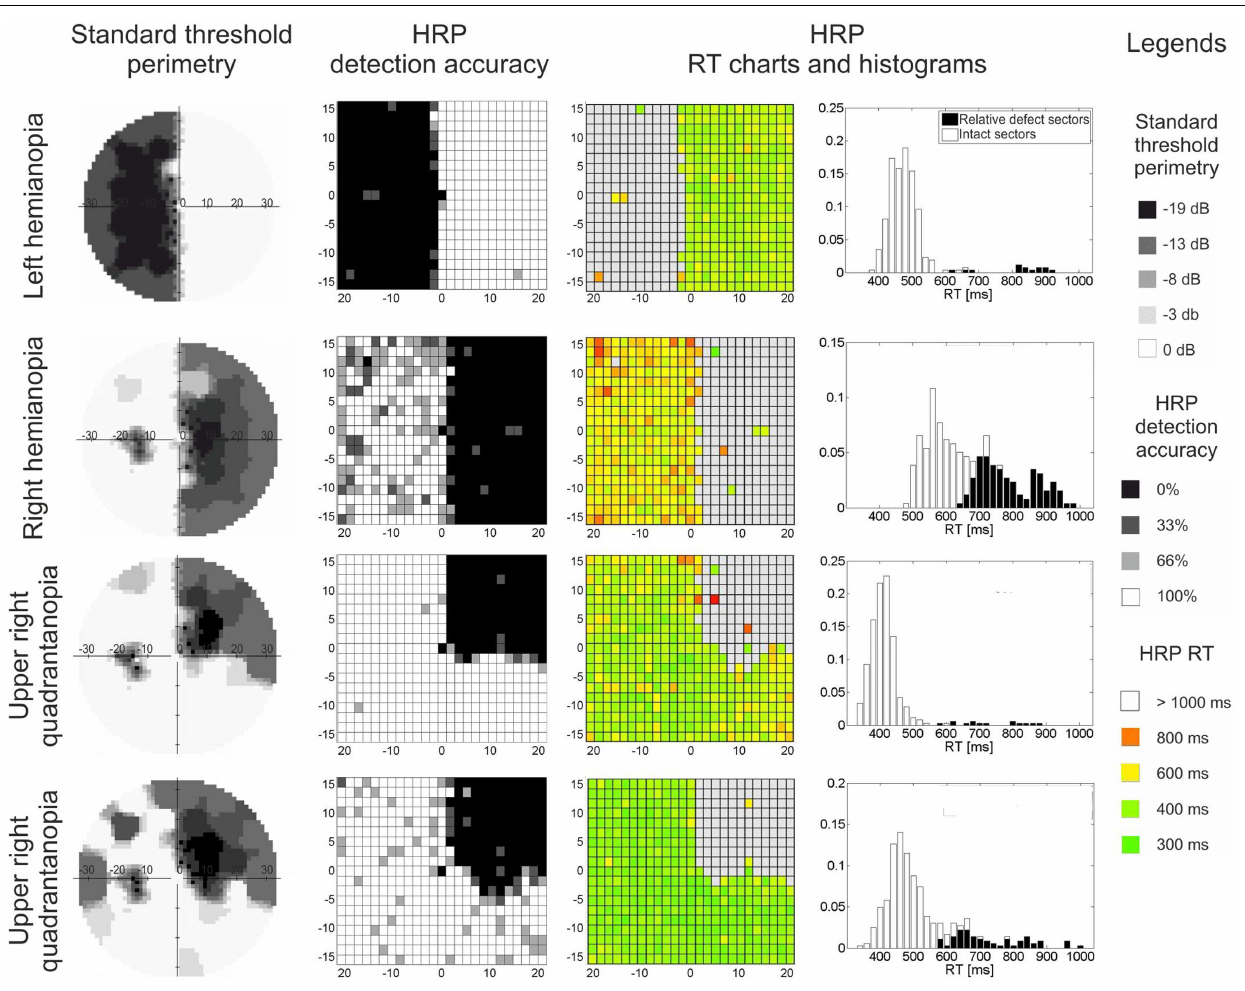
FIGURE 1 |Visual field maps of four patients with visual field loss due to post-chiasmatic damage .Two types of visual field maps are shown: standard perimetry and high resolution perimetry (HRP), both showing comparable topographies of the visual field. In both methods, the visual field can be divided into absolute defect areas (black sectors, no detection), relative defect areas (also termed area of residual vision; gray sectors, partial